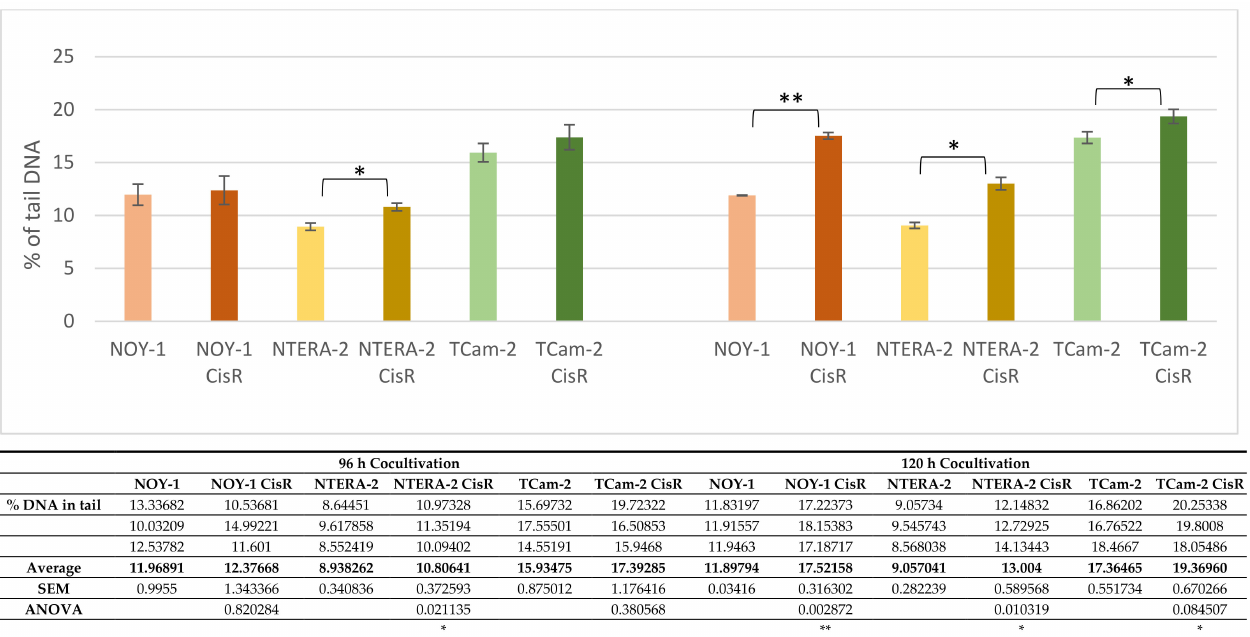
Figure 1. The genotoxic effects of cocultivation of GCT cell lines with PBMCs from healthy donors. The comet assay was used to determine levels of DNA damage in PBMCs after 96 and 120 h of cocultivation with the yolk sac tumor cell line NOY-1, embryonal carcinoma cell line NTERA-2, seminoma cell line TCam-2, and their CDDP-resistant (CisR) variants. Data represent the means ± SEM of three independent experiments (raw data are presented in table below Figure 1). p values (* p < 0.05 and ** p < 0.01) indicate statistically significant differences in DNA damage levels between PBMCs cocultivated